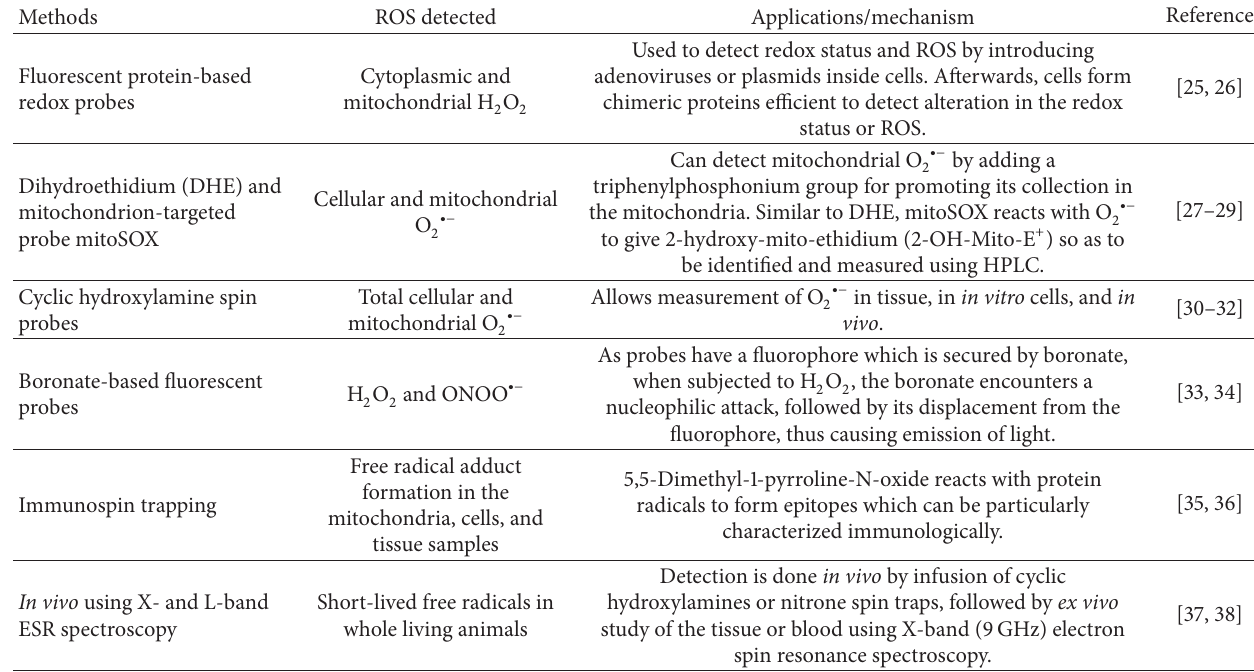
Table 1: Direct methods for detection of ROS in